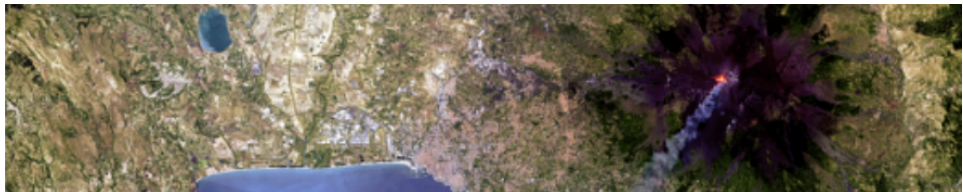
Figure 10. Sentinel-2 printed image for on board model